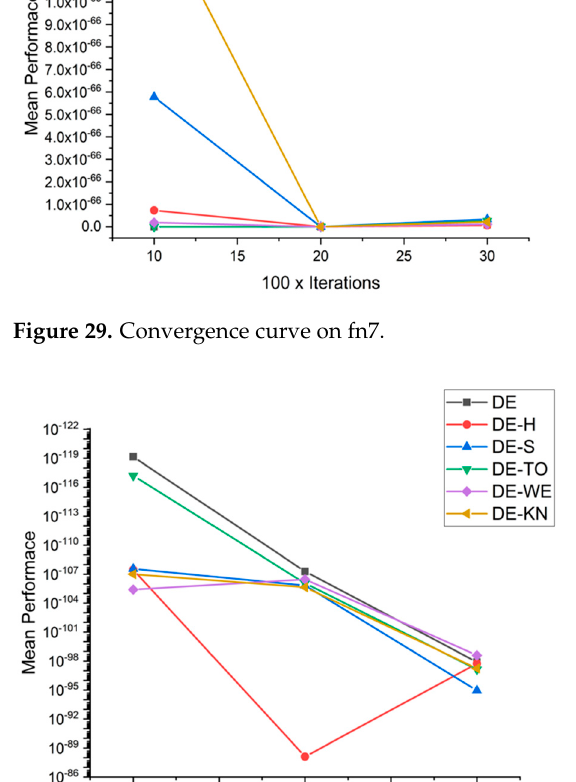
Figure 30. Convergence curve on fn8.